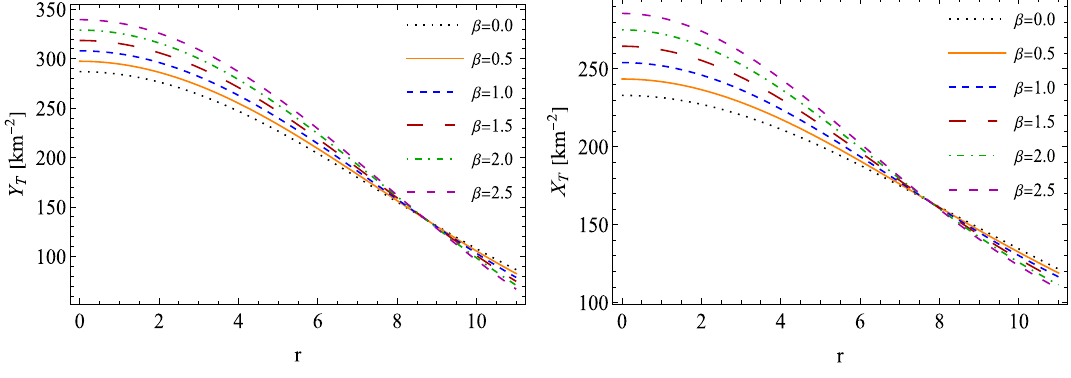
Fig. 3 The left panel and right panel show the trend of scalars Y T × 10 4 and X T × 10 4 versus r for solution 5.1 that describe the strong energy condition and homogeneous energy density distribution. We use the same data set of values as used in Fig.1